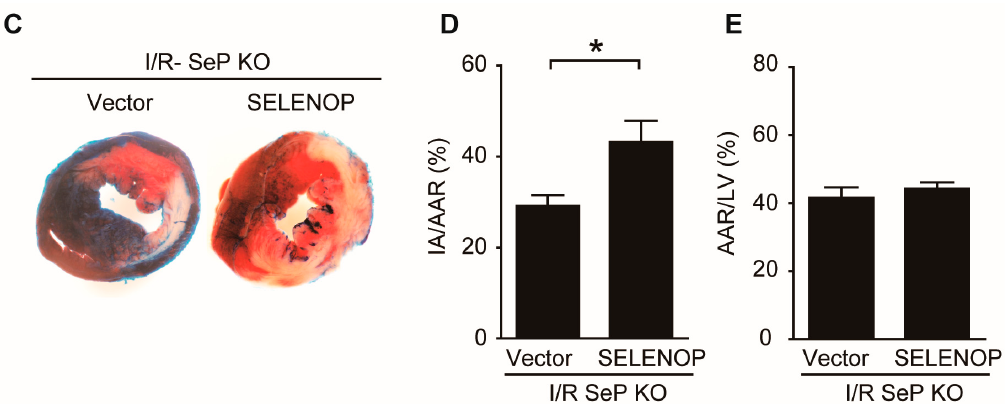
Figure 4. Hepatic overexpression of SeP enhances I/R injury. ( A ) Level of human SELENOP mRNA in the liver of SeP KO mice injected with plasmid DNA and that of mouse SeP mRNA in the liver of WT mice. ( B ) Level of human SELENOP mRNA in the heart of mice injected with plasmid DNA. SeP KO mice, injected with SELENOP plasmid and control into the tail vein, were subjected to 30 min of ischemia and 24 h of reperfusion. ( C ) Representative examples of myocardial infarction stained with EB and TTC after 24 h reperfusion ( n = 3/control plasmid, n = 6/SELENOP plasmid). ( D ) The myocardial IA/AAR (percentage of IA/AAR) is shown. ( E ) AAR/LV size ratio is shown. Data represent means from at least five mice each. * p < 0.05.